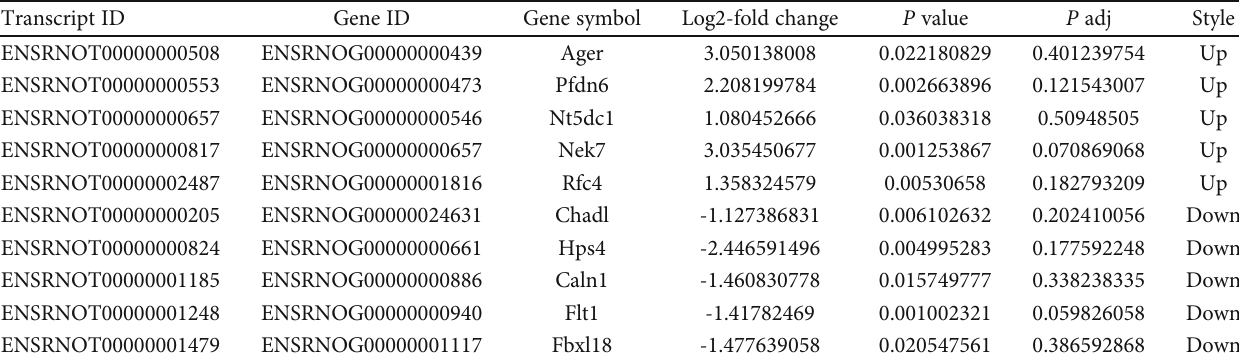
Table 2: The partially DETs from RNA-Seq